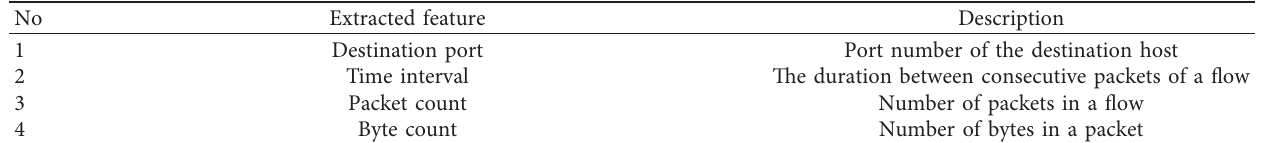
Figure 3: Architecture of the proposed IDS system. Table 2: Description of features to be collected from the